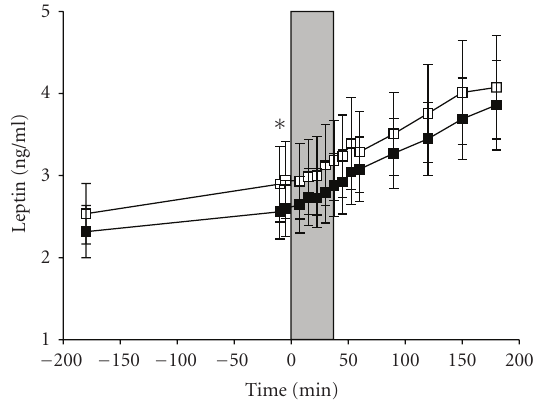
Figure 2: Mean ( ± SEM) plasma leptin concentrations in the hypoxic (white squares) and the control (black squares) condition. Gray area marks the time of hypoxic/normoxic intervention. The red label marks the point of time leptin has significantly increased. The time course describes the period before and after the hypoxic intervention was initiated (Time point